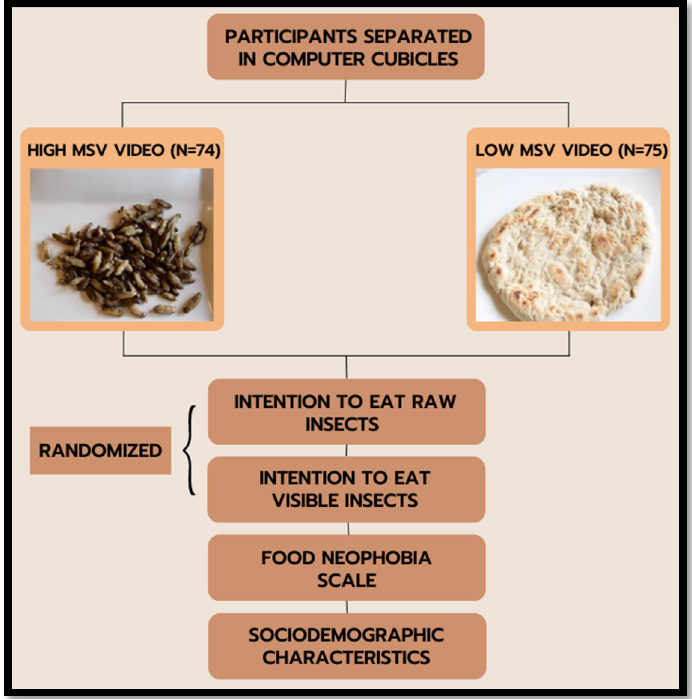
Figure 2. Flow of the